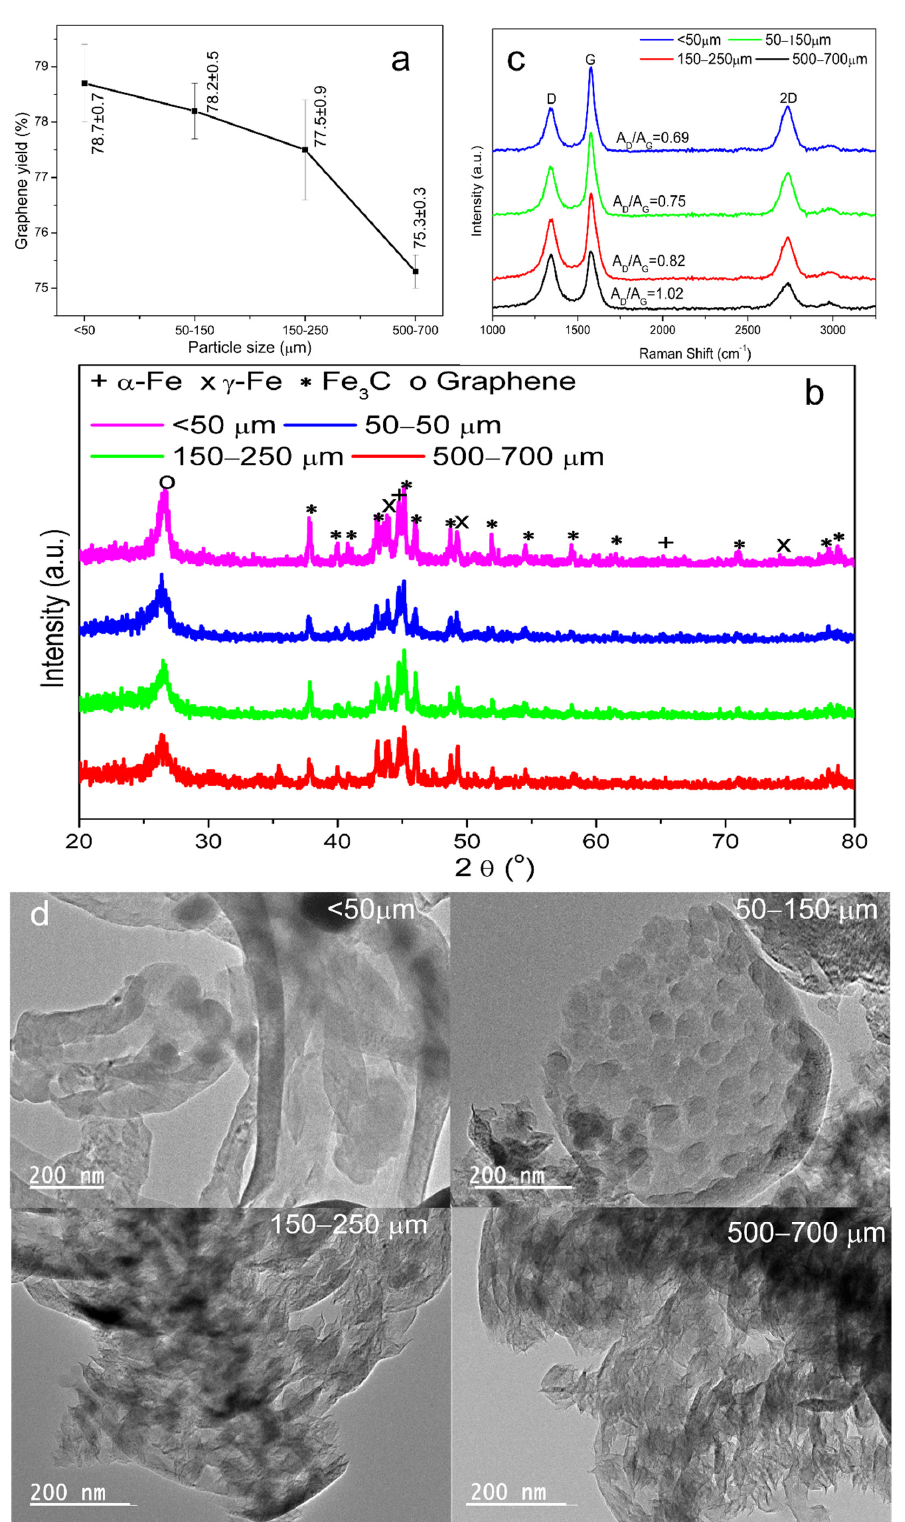
Figure 7. Yield of graphene materials ( a ), XRD patterns ( b ), Raman spectra ( c ), and HRTEM ( d ) images of the cracked GEIN samples from different GEIN grain particle sizes through MCW at 1000 ◦